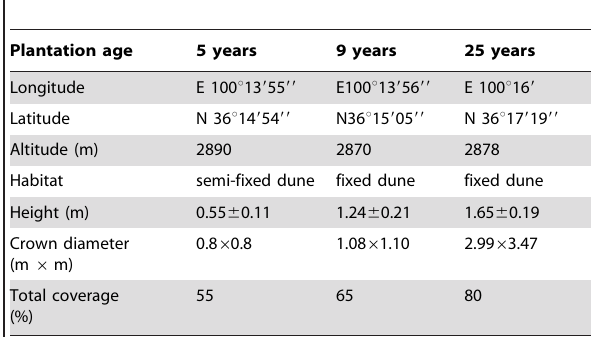
Table 2. Community characteristics in three ages of Caragana intermedia